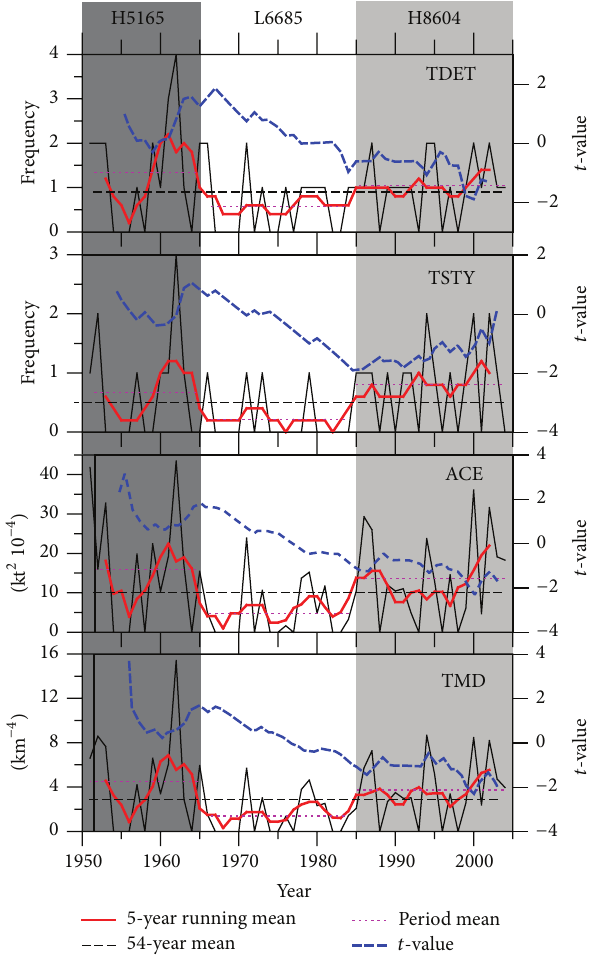
Figure 1: Decadal variation related to a Korea-landfall TC activity. Indices in order from an upper-most side are the total TC frequency (F-TDEC), the TC frequency with intensity greater than tropical storm (TS) (F-TSTY), Accumulated Cyclone Energy (ACE) of TC with intensity greater than TS, and total moving distance (TMD) for the TC lifetime, respectively. The periods of H5165, L6685, and H8604 indicate the first high frequency period for 1951–1965, the low frequency period for 1966–1985, and the second high frequency period for 1986–2004 defined by 𝑡 -value (thick blue line) of the statisticalchange-pointanalysis.Thethickred,blackdashed,andred dotted lines denote 5-year running mean, 54-year mean, and each period mean,